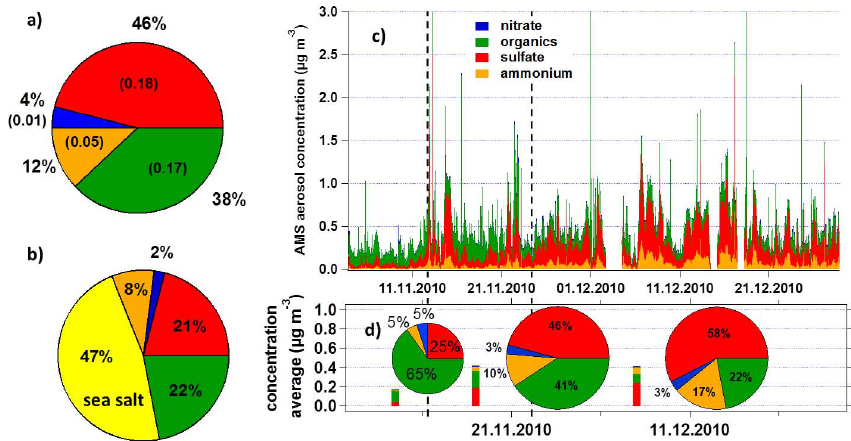
Fig. 3. (a) Average mass contribution of individual chemical species (the numbers in parentheses indicate the average mass concentration in µgm − 3 ) . (b) Average mass contribution of individual chemical species including sea salt, up-scaled from the NaCl + signal based on Ovadnevaite et al. (2012). (c) Stacked time series of AMS-measured aerosol mass concentrations. (d) Average mass concentration for three time periods (3–12 November, 12–22 November, 22 November–28 December, indicated by the dashed vertical bars) and the respective relative composition (the area of the pie charts reflects the overall